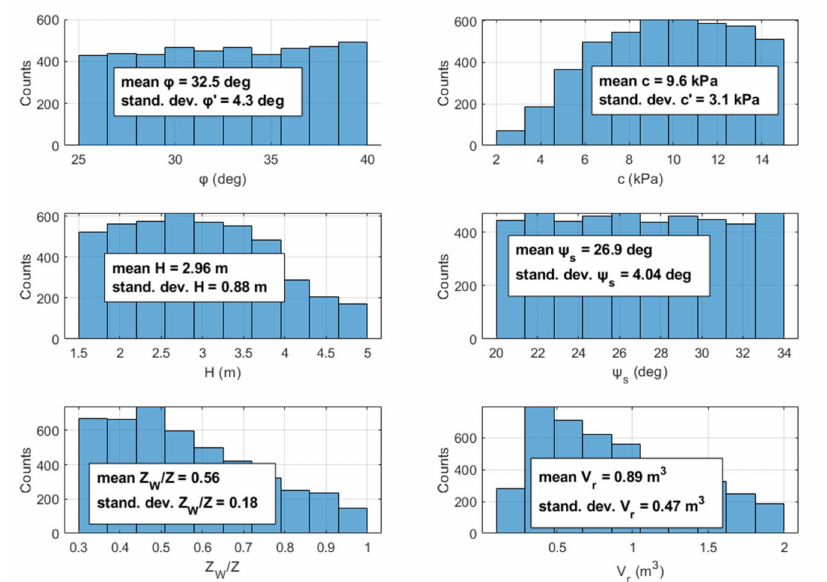
Figure 7. Results of back-analysis procedure for the critical dip vectors of planar sliding, in terms of material strength properties of discontinuities and geometrical features of